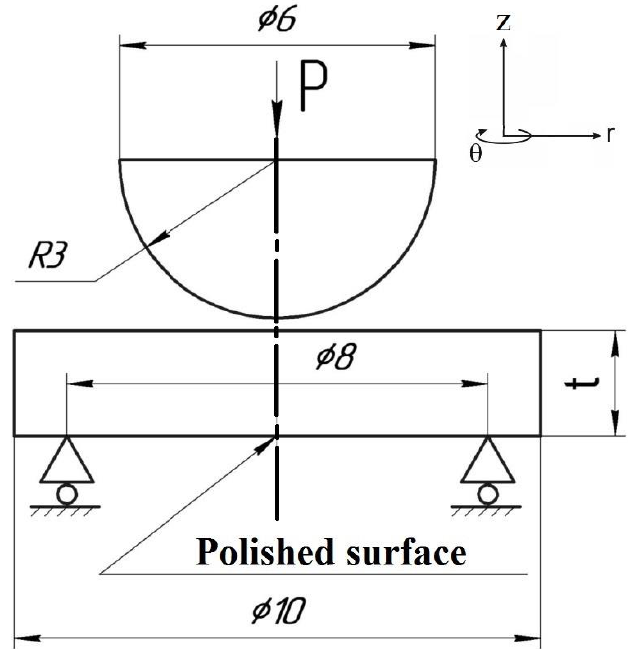
Figure 2. The loading scheme of disk specimens in autoclave. t = 1.5 mm for 12Cr F/M steel, irradiated at T irr = 390 ◦ C; t = 1.9 mm for 12Cr F/M steel, irradiated at T irr = 550 ◦ C.